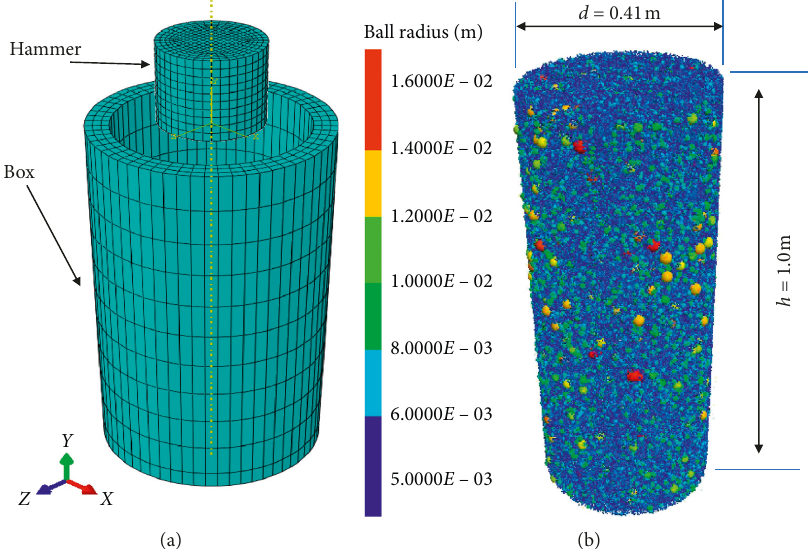
Figure 1: (a) Full-scale hammer and box models in the continuous domain; (b) the DEM model replicating the particle size distribution of laboratory tests.